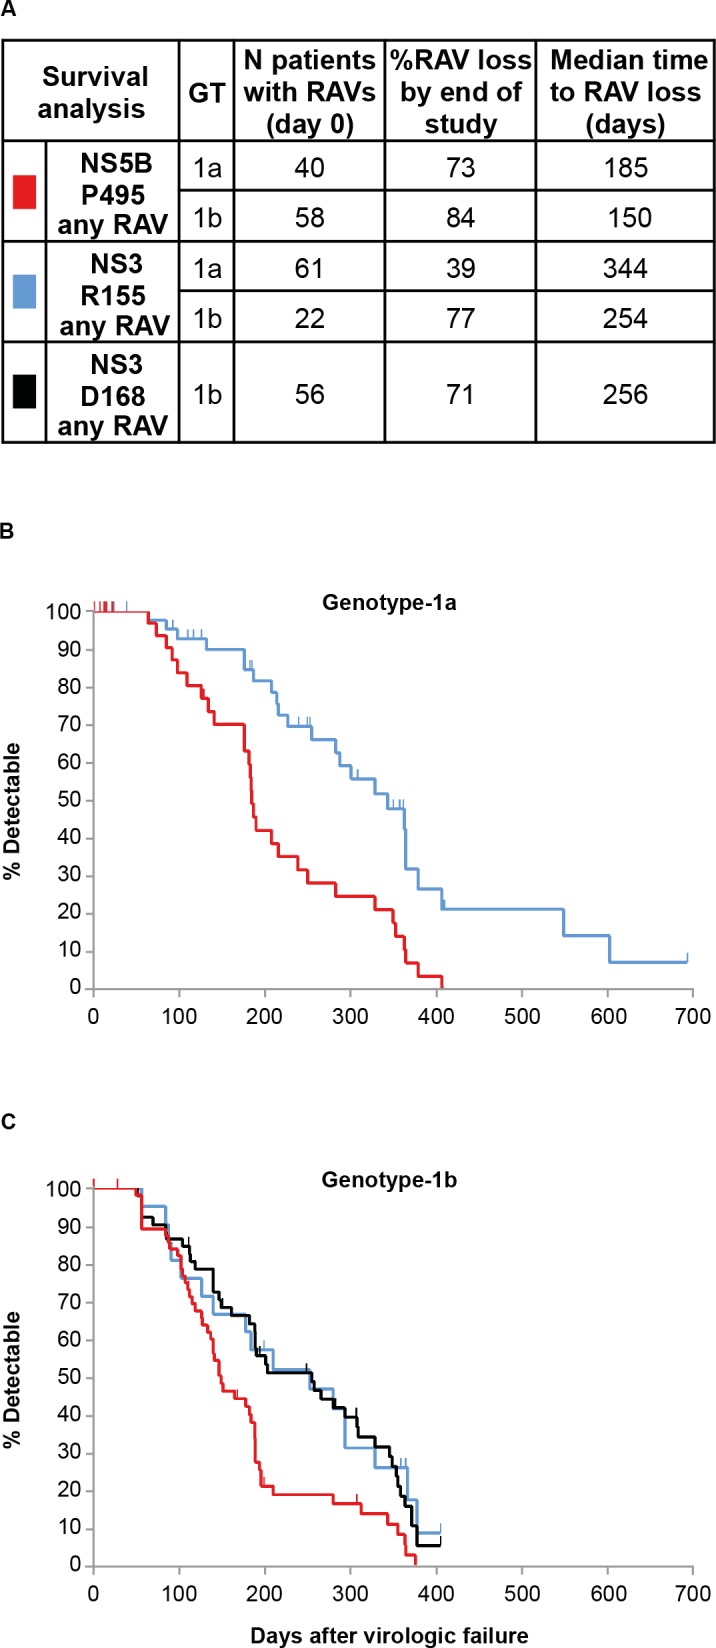
Persistence of NS3 and NS5B RAVs among patients who did not achieve SVR12 with faldaprevir/deleobuvir/RBV and did not receive PegIFN/RBV rescue therapy.(A) Kaplan–Meier estimation of time to loss of RAVs (population-based sequencing); (B) Phase 2 studies SOUND-C2 and SOUND-C3. (C) Phase 3 studies HCVerso1 and 2. Median time to RAV loss: time to wild-type amino acid detection (with concomitant loss of RAVs) in 50% of patients. Vertical marks: RAV detected, but subsequent sequence not available. GT, genotype; PegIFN, pegylated interferon; RAV, resistance-associated variant; RBV, ribavirin; SVR12, sustained virologic response 12 weeks after treatment.